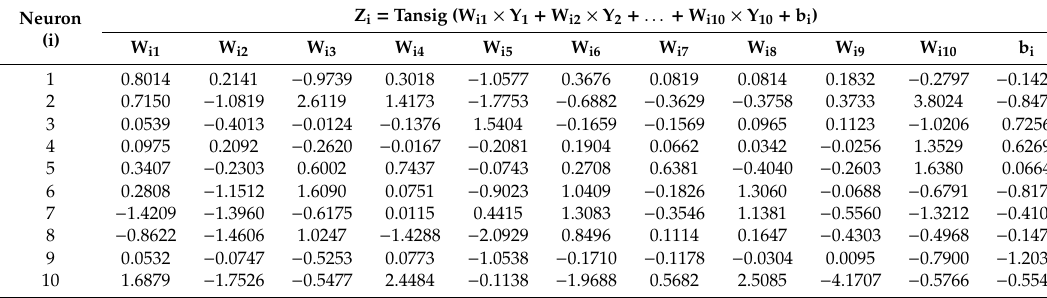
Table 6. Weight and biases of the ANN model.